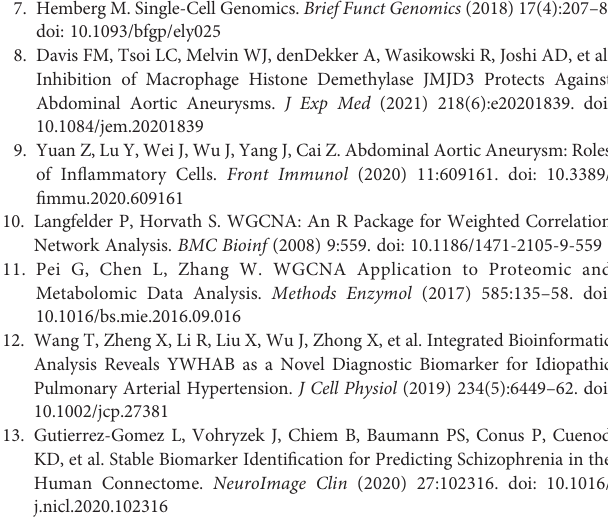
Supplementary Figure 1 | Visualization of immune cell in fi ltration and G0S2 correlation analysis results based on GSE57691. (A) Correlation analysis between the expression of G0S2 and neutrophils. (B) Correlation between G0S2 and activated mast cells. (C) Correlation analysis of G0S2 and M0 macrophage expression. (D) Correlation analysis between the expression of G0S2 and regulatory T cells (Tregs). (E) Correlation analysis between the expression of G0S2 andrestingmastcells. (F) Correlationanalysisintheexpressionof G0S2 andresting dendritic cells. (G) Correlation analysis of the expression of G0S2 and resting CD4 memory T cells. (H) Correlation between G0S2 and M1 macrophage expression. Supplementary Figure 2 | Visualization of the results of immune cell in fi ltration and HSPE correlation analysis based on GSE57691. (A) Correlation analysis of G0S2 and M0 macrophage expression. (B) Correlation analysis in the expression of G0S2 and activated mast cells. (C) Correlation analysis between the expression of G0S2 and regulatory T cells (Tregs). (D) Correlation analysis of the expression of G0S2 and resting memory CD4 T cells. (E) Correlation analysis of G0S2 and M1 macrophage expression. (F) Correlation between G0S2 and resting mast cells. Supplementary Table 1 | “ SingleR ” package was used to annotate the cells and produce 20 clusters. Supplementary Table 2 | The “ FindMarkers ” method was used to identify genes that differed signi fi cantly between AAA and normal cells. Supplementary Table 3 | All modular genes obtained from WGCNA. Supplementary Table 4 | DEGs between AAA and normal samples. Supplementary Table 5 | DEGs between large AAA and small AAA samples. Supplementary Table 6 | Results of immune cell in fi ltration between AAA and normal samples. Supplementary Table 7 | Results of immune cell in fi ltration between large and small AAA